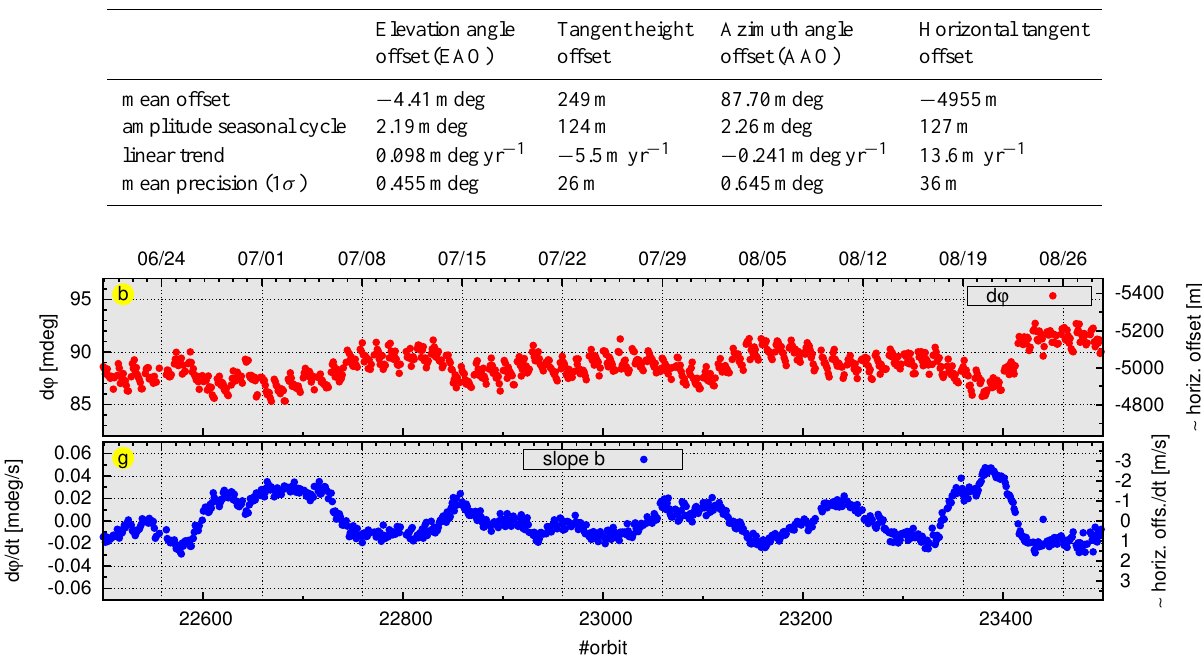
Table 3. Summary of the statistical quantities of the observed elevation and azimuth angle offsets for SCIAMACHY’s solar occultation measurements. The corresponding vertical and horizontal offsets at the tangent point are also listed.